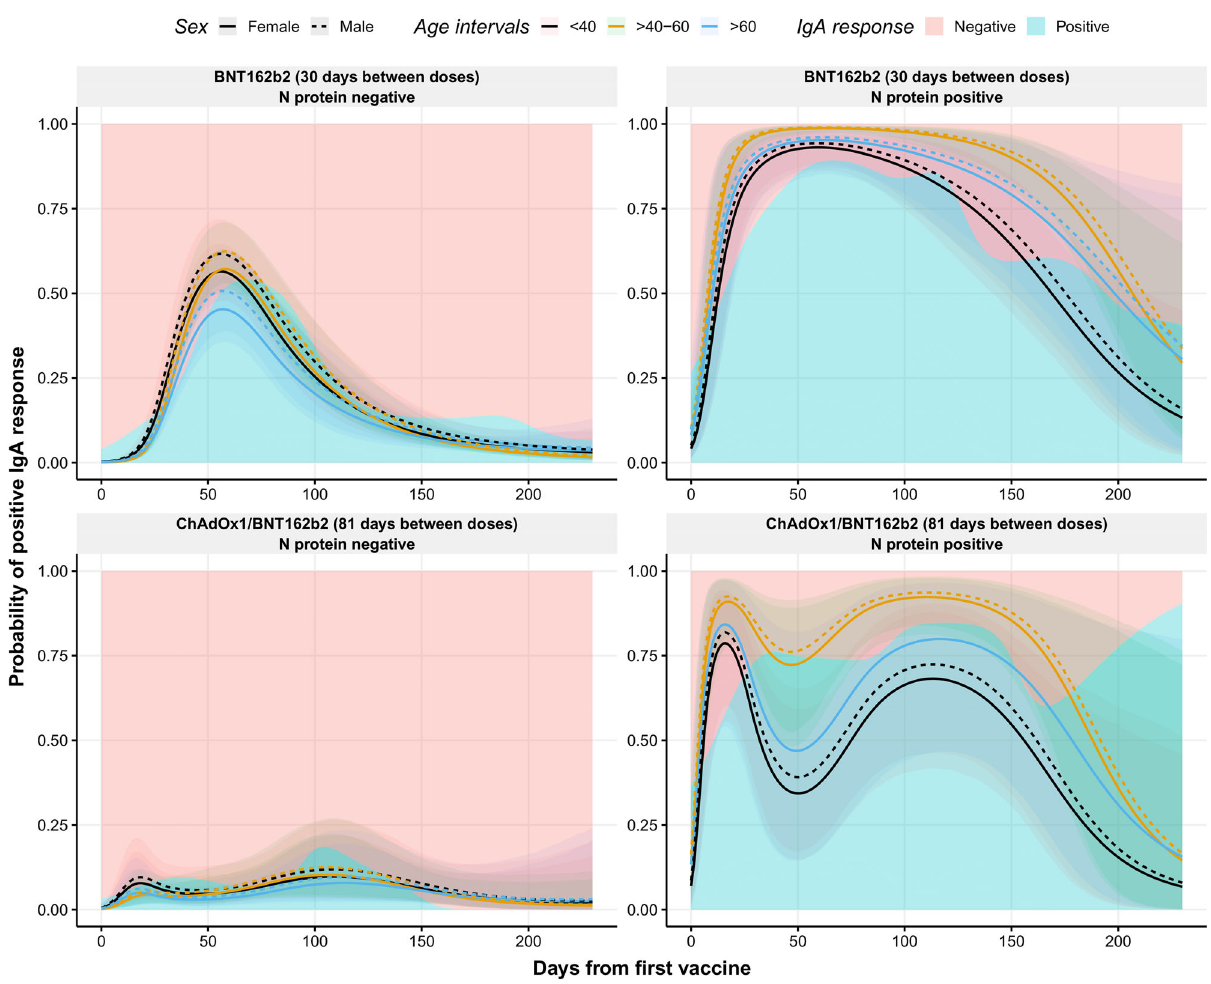
Fig. 3 Observed and predicted probability of positive IgA responses against RBD after the fi rst dose of the COVID-19 vaccination. Distribution of positive IgA response (probability) over time (days from the fi rst vaccine) in individuals with no prior infection vaccinated with BNT162b2 (top left) or with the combination ChAdOx1/BNT162b2 (bottom left), and in individuals previously infected and vaccinated with BNT162b2 (top right) or with the combination ChAdOx1/BNT162b2 (bottom right). Blue and pink backgrounds represent the conditional density estimation of positive and negative IgA responses, respectively. Solid and dashed lines represent the predicted probability of positive IgA responses calculated by the model in females and males, respectively. Black, yellow, and blue colors represent individuals with age <40, 40 – 60, and >60 years, respectively. Shadowed areas represent the 95% con fi dence interval. Center for the con fi dence interval is the predicted (mean)